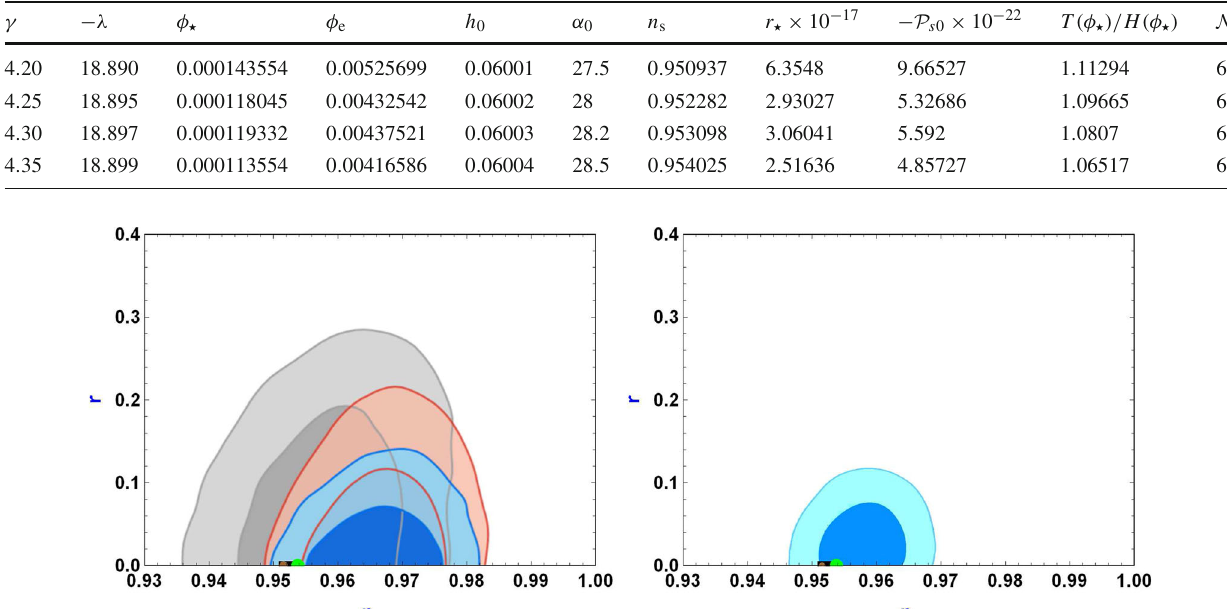
Table 4 Estimation of the free parameters of the non-comoving warm inflationary model with generalized de Sitter scale factors by using the Planck 2013, 2015 and 2018 data sets, and with C γ = 55, and n = 1, respectively. We have restricted our analysis to real values of the scalar